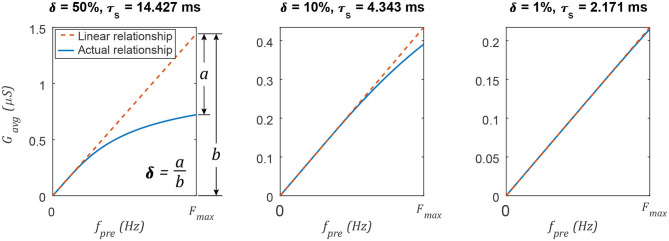
Decreasing the synaptic time constant τs increases the linearity of the average synaptic conductance Gavg as a function of the pre-synaptic neuron's spiking frequency fpre. Changing the network's maximum spiking frequency Fmax will change the specific value of τs, but the linearity δ varies in the same way.